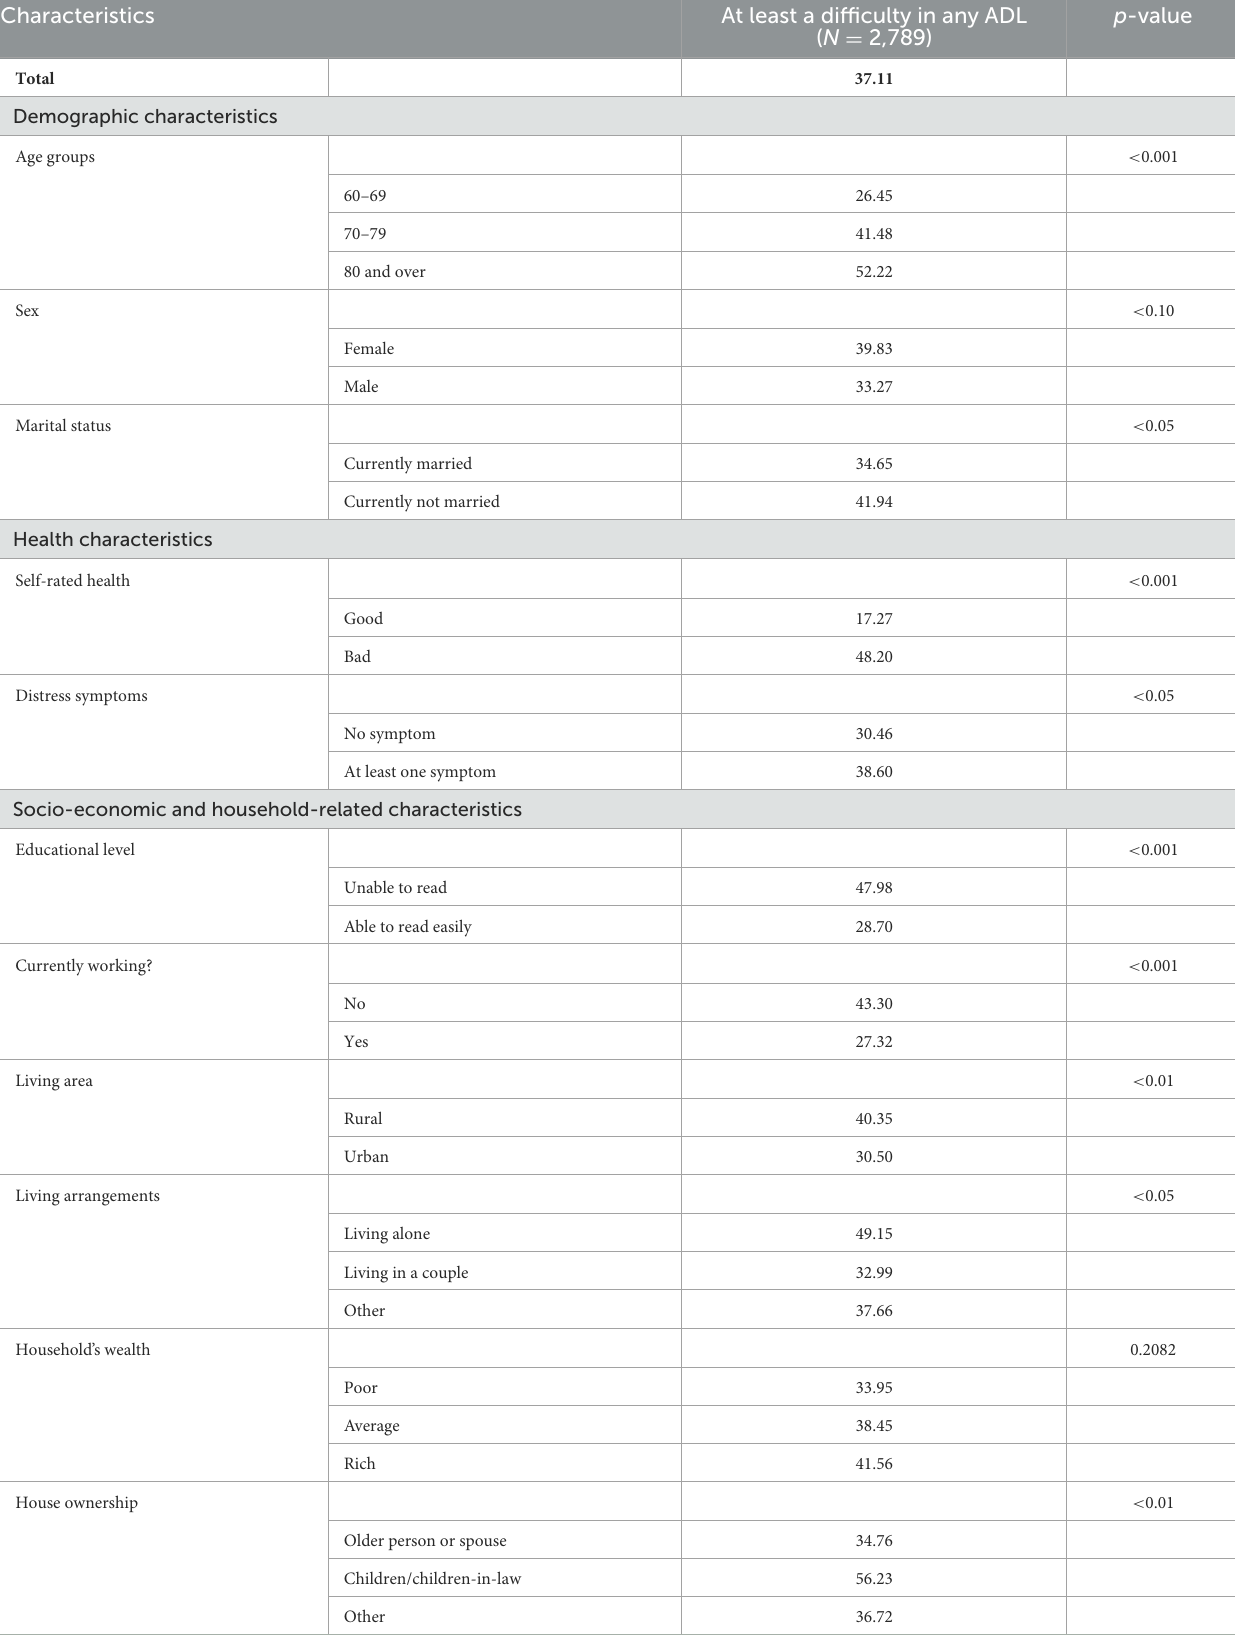
TABLE 1 Percentage of older people with at least a difficulty in any